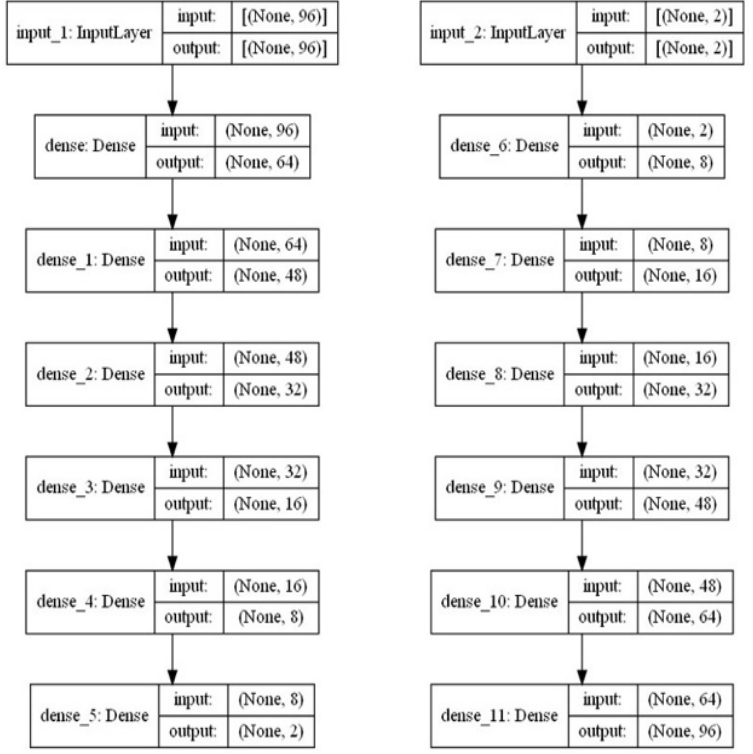
Figure 3. Structures of the encoder (left) and decoder (right).